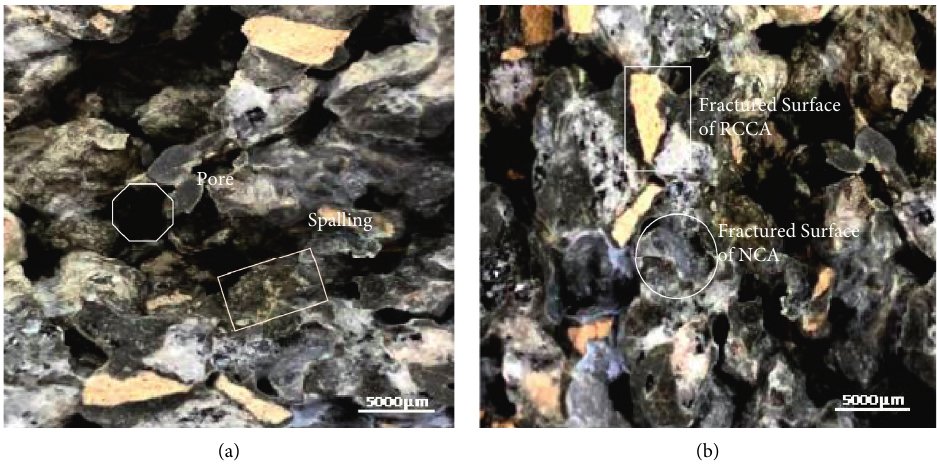
Figure 5: Fracture morphology of RCCA 20 and RCCA 40 after compression test. (a) RCCA 20 . (b) RCCA 40 .